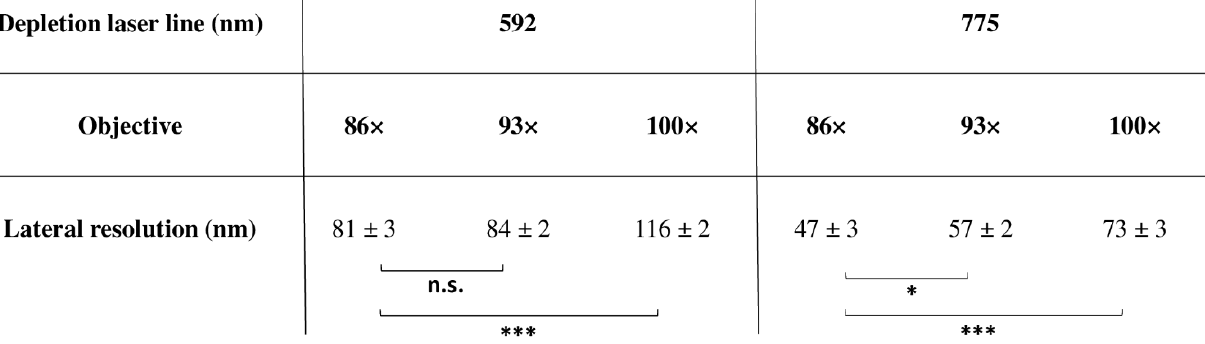
132 141 132 145 146 147 148 139 140 141 142 144